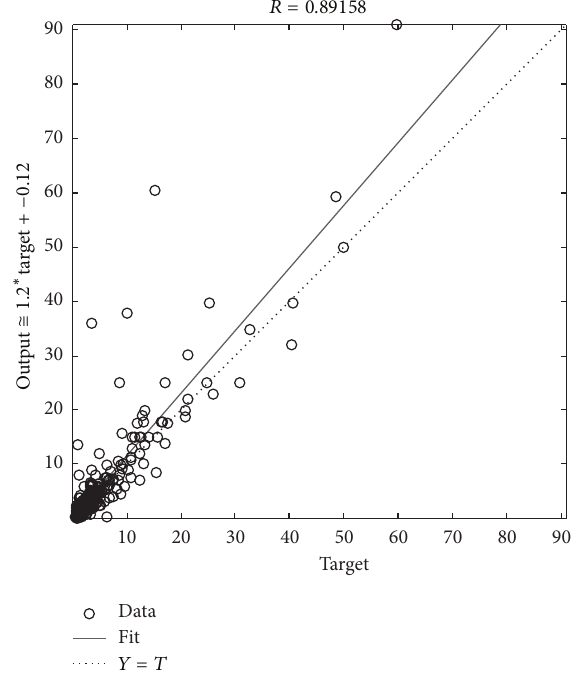
Figure 14: GP steel expression using logarithmic error.